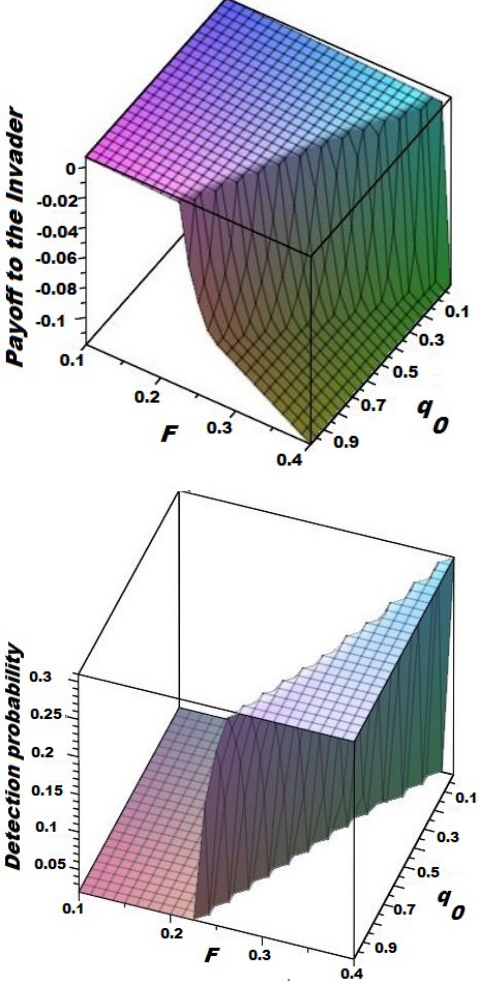
0 the Invader with reward un-related to the bandwidth